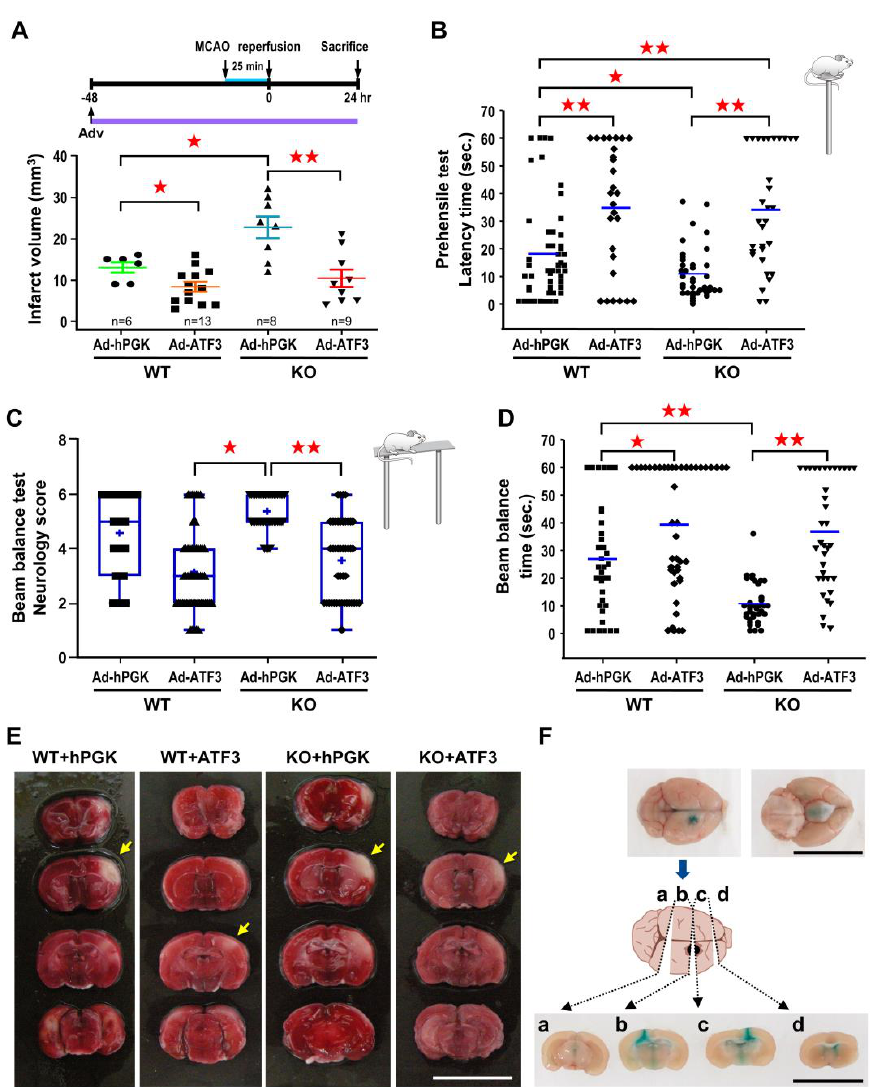
Figure 4. ATF3 overexpression rescues brain infarct and neurological deficits in ATF3 KO mice. ATF3 KO or WT mice were subjected to icv infusion of 2 × 10 5 pfu of Ad-ATF3 or Ad-hPGK at 48 h prior to 25 min of ischemia and infract volume was determined at 24 h of reperfusion. Brain infarct volumes are quantified in panel ( A ). Each dot represents a data point from an individual animal. Behavior tests based on prehensile test ( B ) or beam balance test ( C , D ) were performed at 24 h of reperfusion. Data are expressed as mean ± SD ( n ≧ 6). ★ p < 0.05 and ★★ p < 0.01 between groups. Representative images of brain infarct are shown in panel ( E ); white area represents infarct area (yellow arrow). Periodic confirmation of proper placement of the needle was performed with infusion of fast green ( F ). (Bars = 1 cm). ATF3: activating transcription factor 3; Ad-hPGK: rAd-carrying hPGK promoter; hPGK: human phosphoglycerate kinase; rAd: replication-defective recombinant adenoviral; Ad-ATF3: rAd-carrying hPGK promoter-driven ATF3 gene; MCAO: middle cerebral artery occlusion.